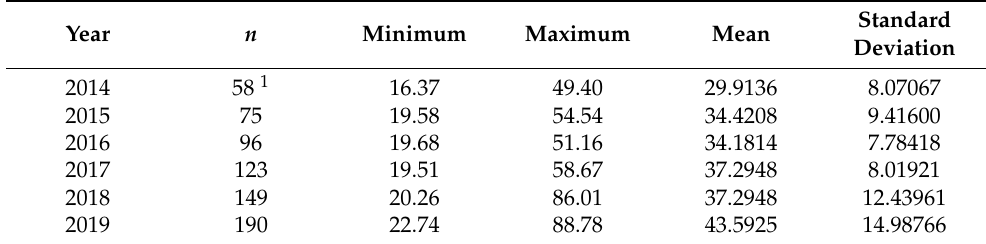
Table 4. Descriptive statistics of weighted time accessibility index of the Wuhan rail transit network.